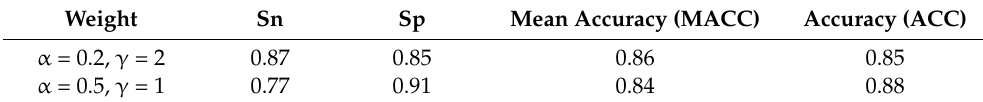
Table 1. Comparison of classification performance with weight ( α = 0.2) and without weight ( α =